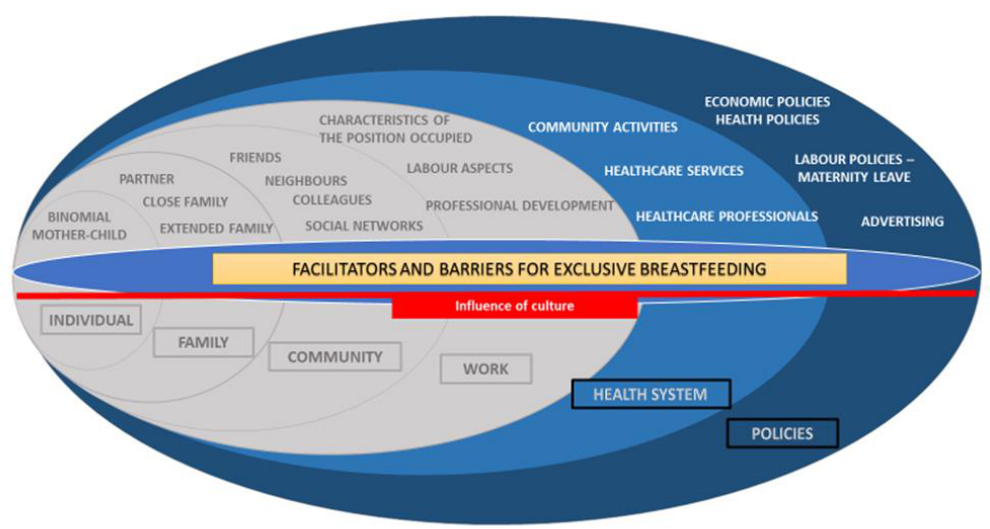
Figure 1. Barriers and facilitators for exclusive breastfeeding within the health system and public policies according to Primary Care midwives in Tenerife (Canary Islands, Spain). In the present article, we present the results related to the last two categories (in blue): health system and policies. Figure adapted from Llorente-Pulido et al. 2021 (in grey) and adaptation of Bronfenbrenner’s Ecological Model [23,28].